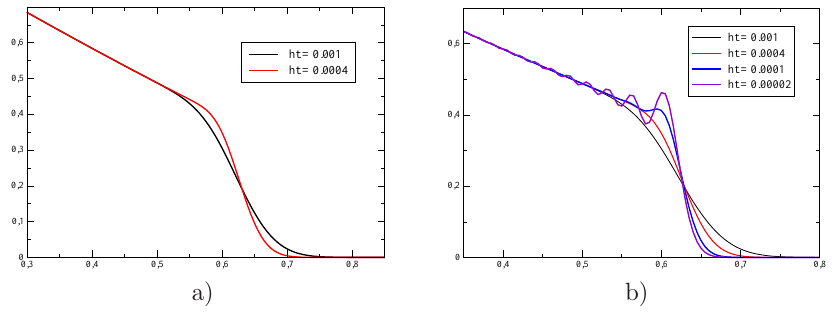
Figure 4. The numerical solutions of problem (5.1) obtained by using the implicit Euler scheme.